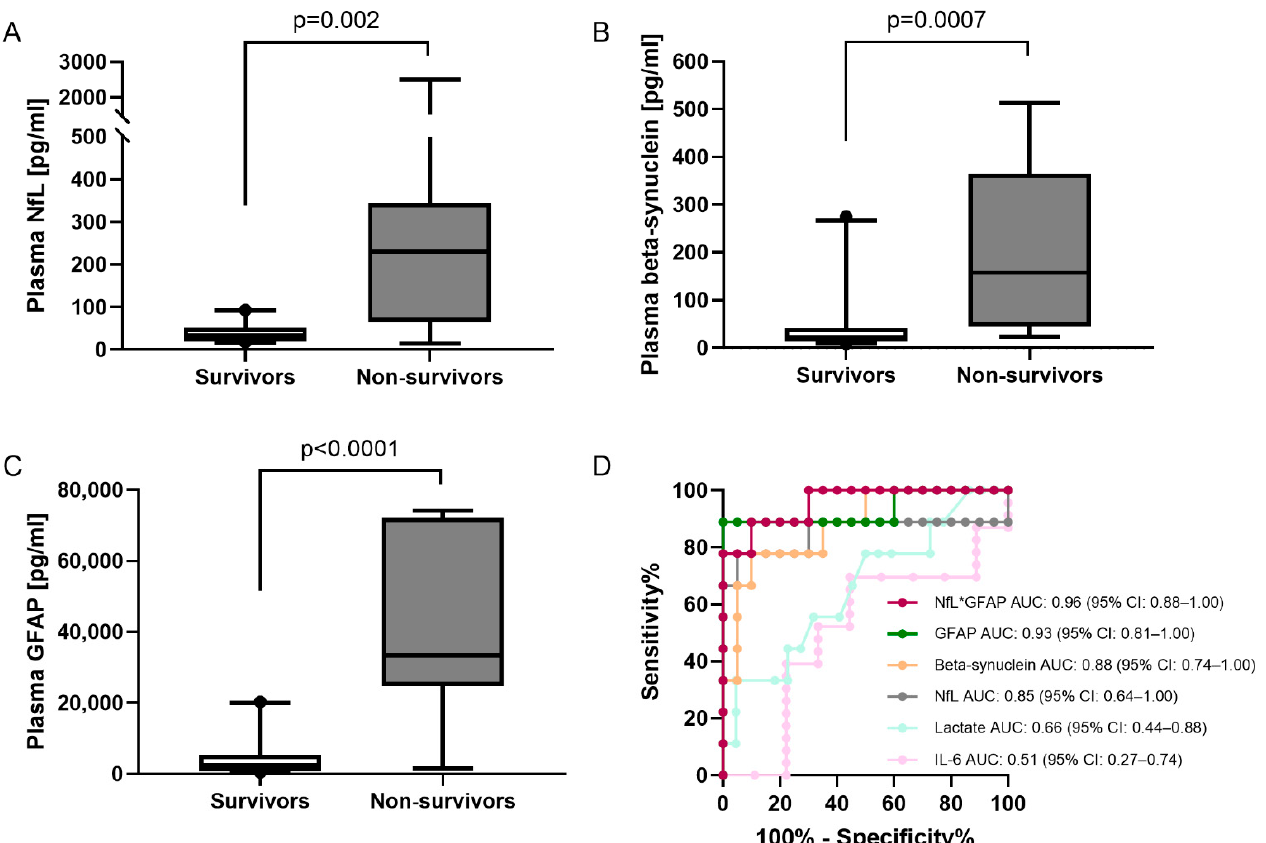
Figure 5. Differences and discrimination between survivors and nonsurvivors. ( A – C ) Differences in initial (0 h) plasma concentrations of NfL ( A ), beta-synuclein ( B ), and GFAP ( C ) between survivors and nonsurvivors. Concentrations are displayed as box plots. The median concentration, the 25% and 75% percentiles, and whiskers from 5% to 95% from n = 20 survivors and n = 9 nonsurvivors are illustrated. Groups were compared by Mann–Whitney U test. ( D ) Comparison of ROC curve analysis for the discrimination between survivors and nonsurvivors for plasma NfL, beta-synuclein, GFAP, lactate, IL-6, and the product of NfL and GFAP. AUC, area under the curve; GFAP, glial fibrillary acidic protein; NfL, neurofilament light chain; ROC, receiver operating characteristic.